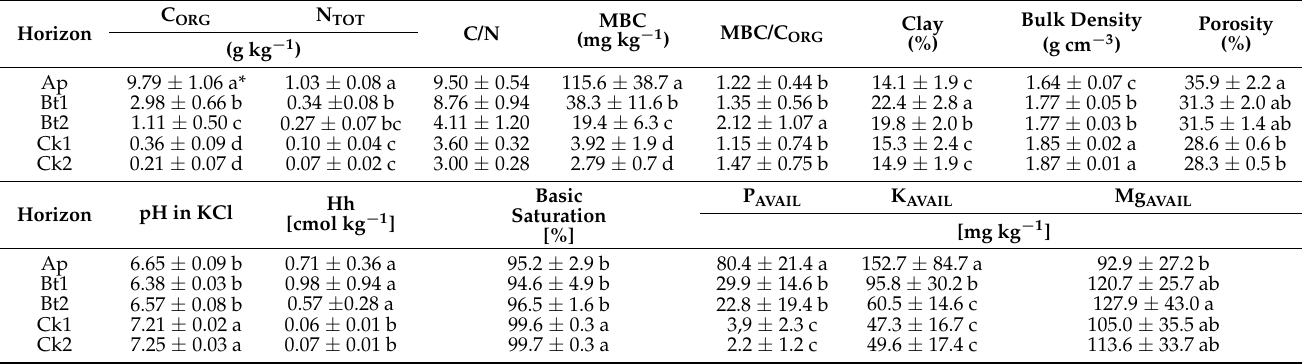
Table 1. Physicochemical properties down the soil profile (mean for 14 profiles).